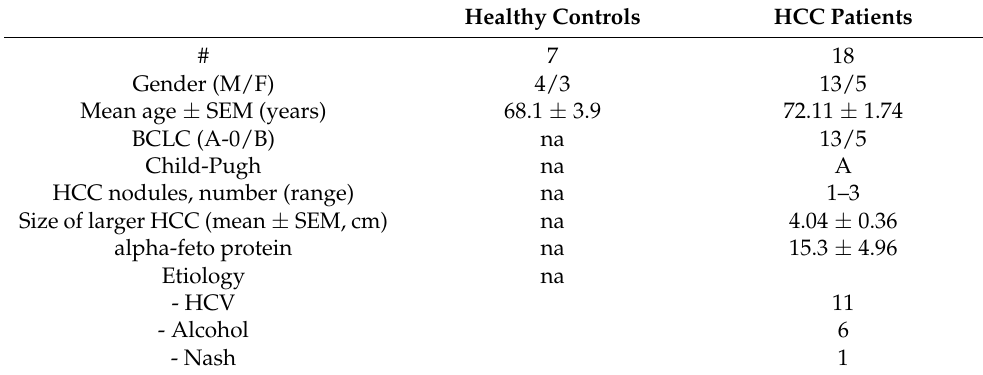
Table 1. Study population.